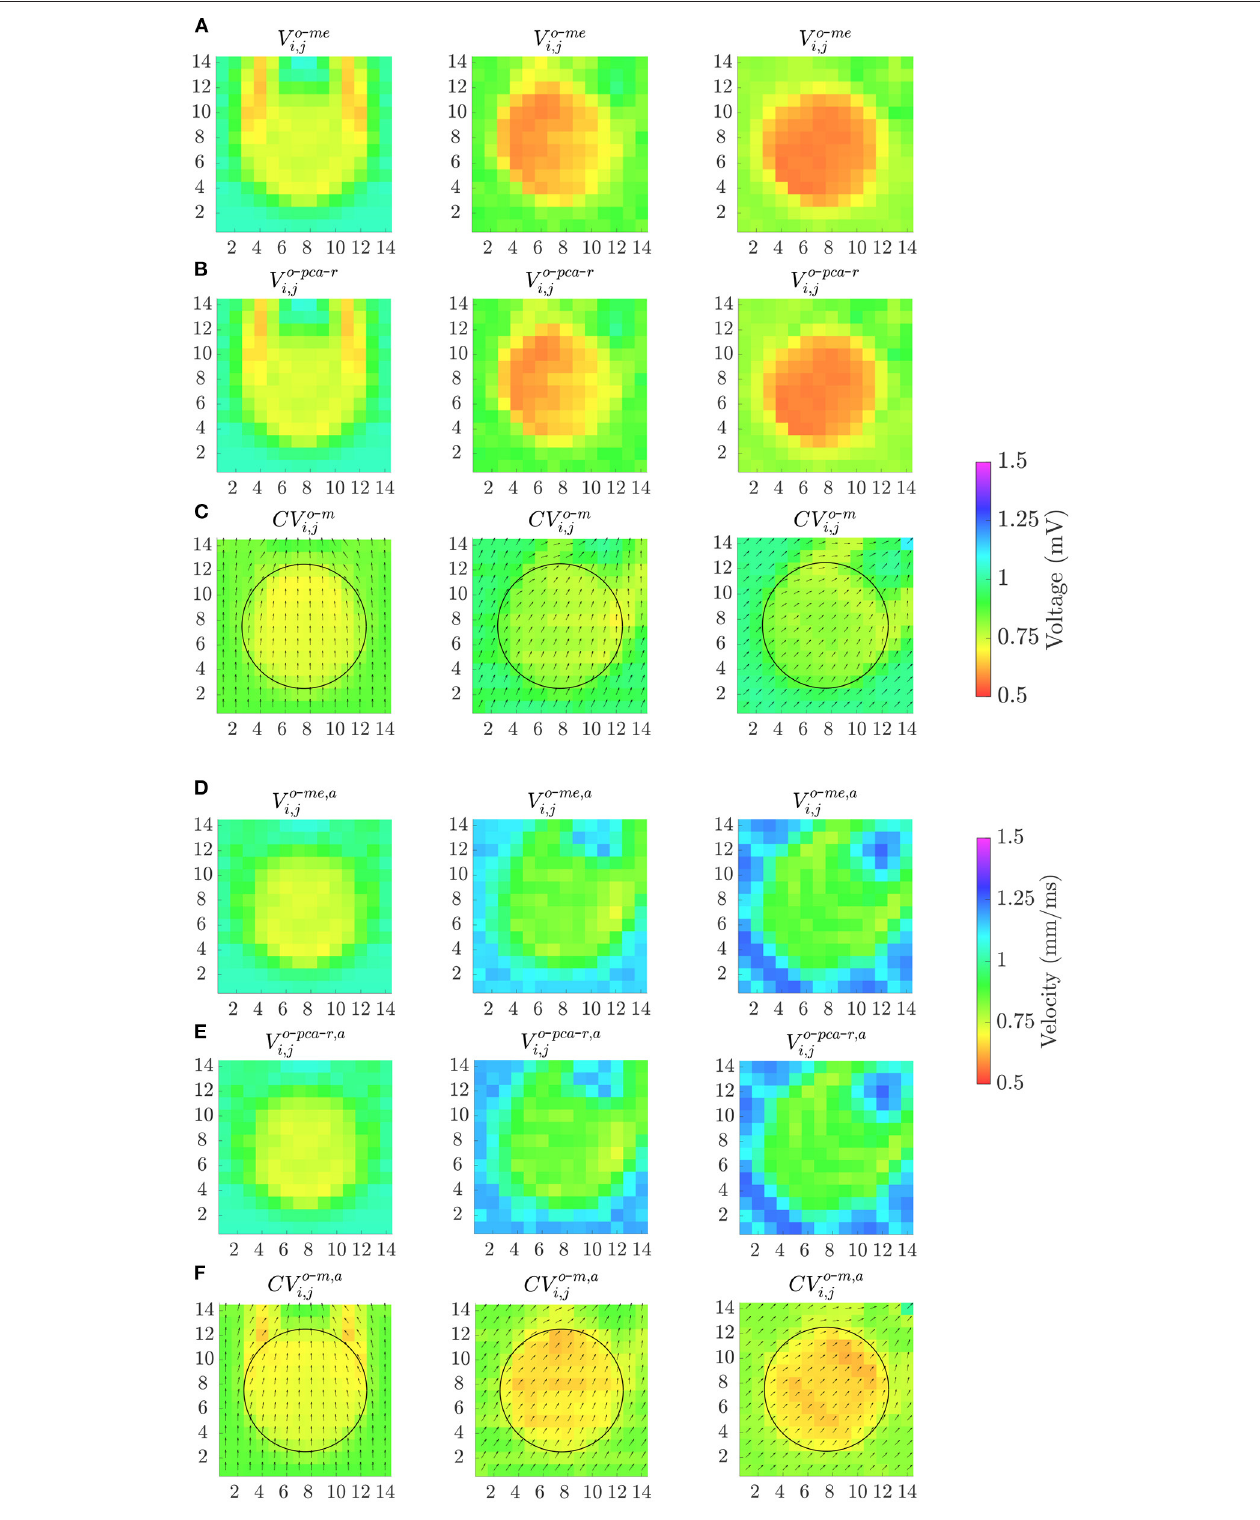
FIGURE 11 | Omnipolar voltage maps (A,B,D,E) and velocity maps (C,F) performed from clean b-EGMs, without (A–C) and with (D–F) previous time alignment, by using square cliques, when: 9 = 0 ◦ (left column); 9 = 30 ◦ (middle column) and 9 = 45 ◦ (right column).